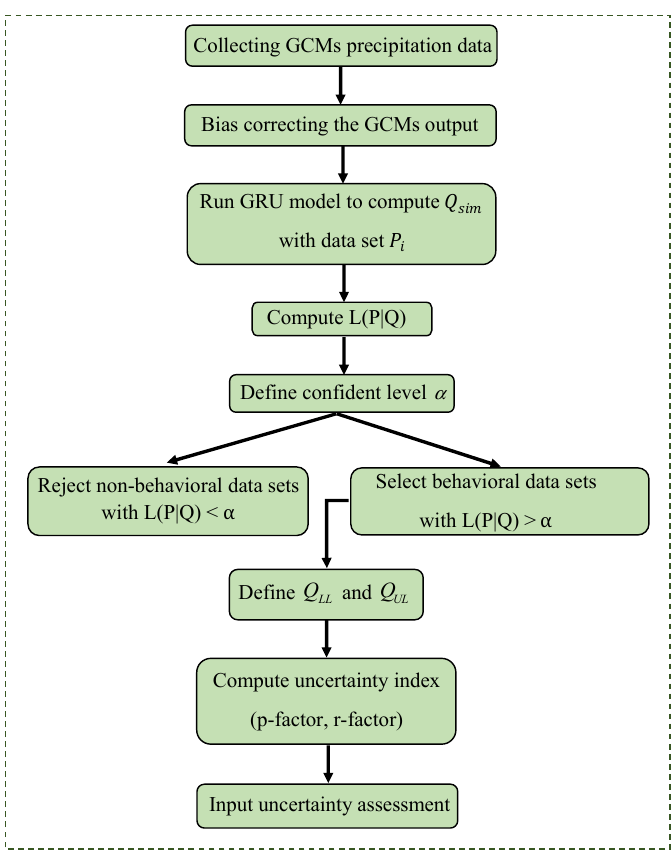
Figure 5. General concept of GLUE method.